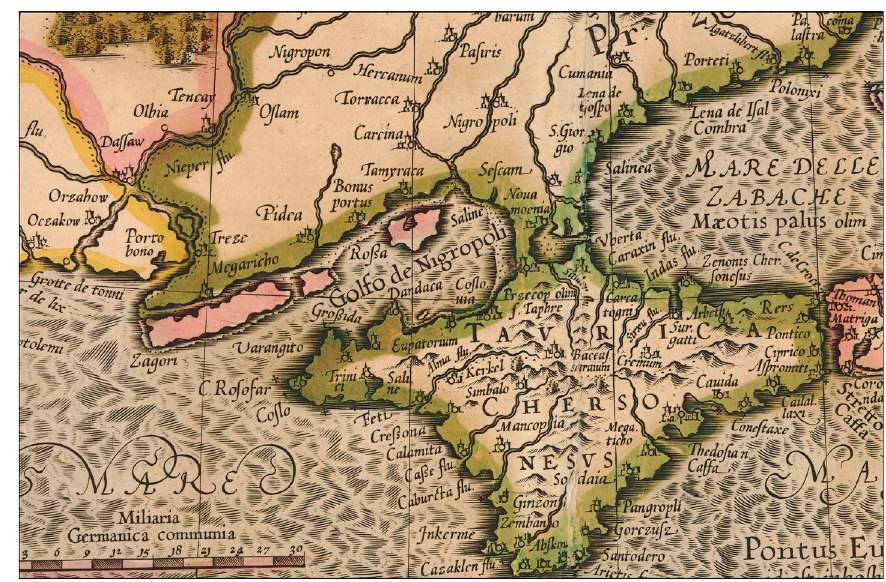
Fig. 5. Part of the map of Taurica Chersonesus by G. Mercator